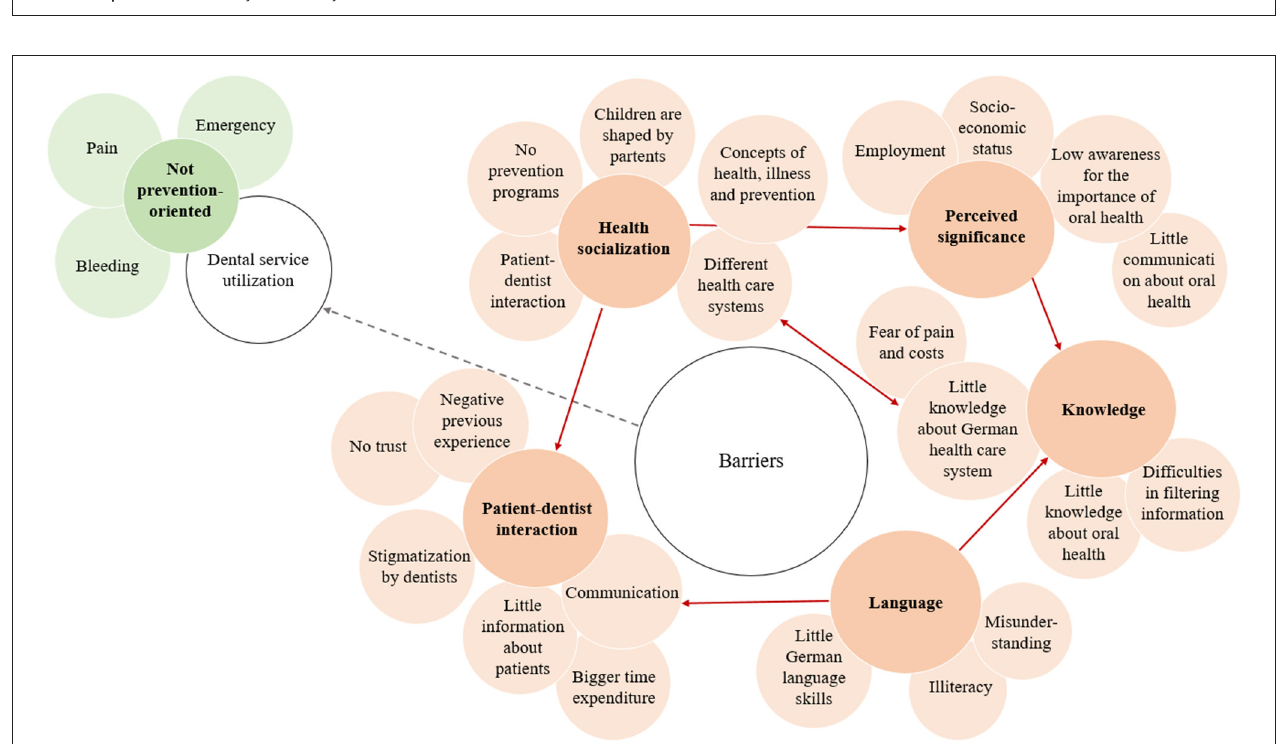
FIGURE 2 | Barriers and reasons for dental visits for migrants in Germany.